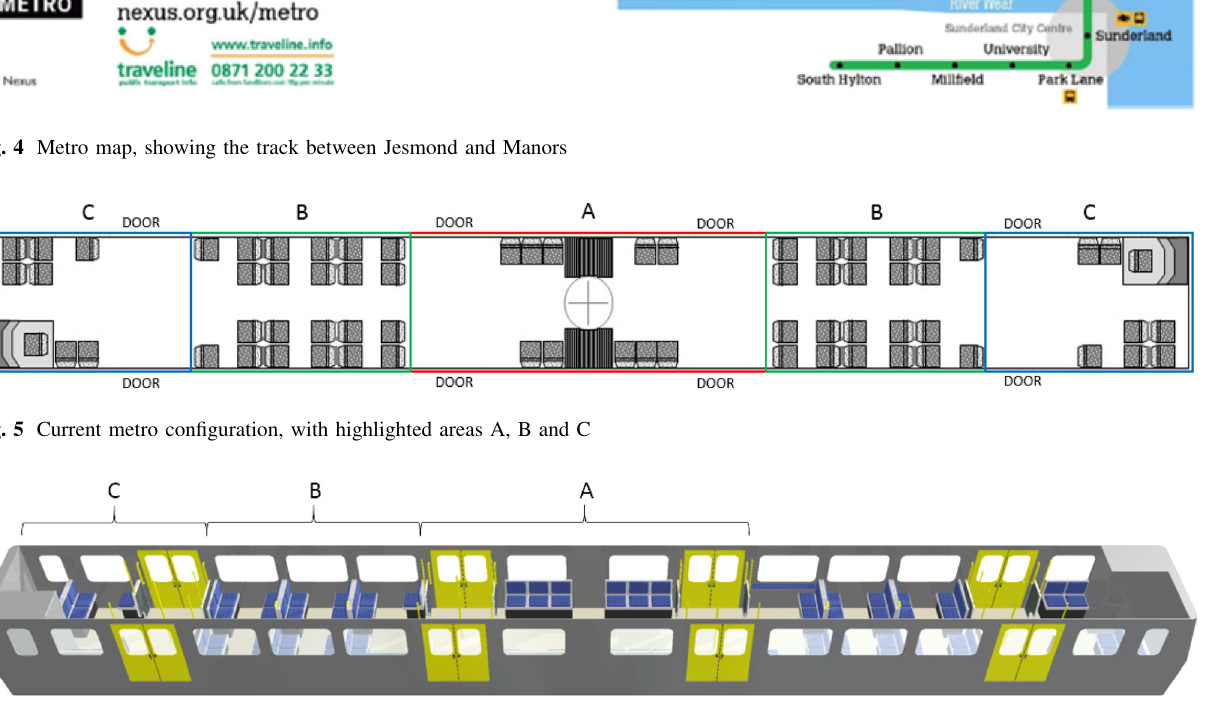
Fig. 6 Autodesk Inventor model of current